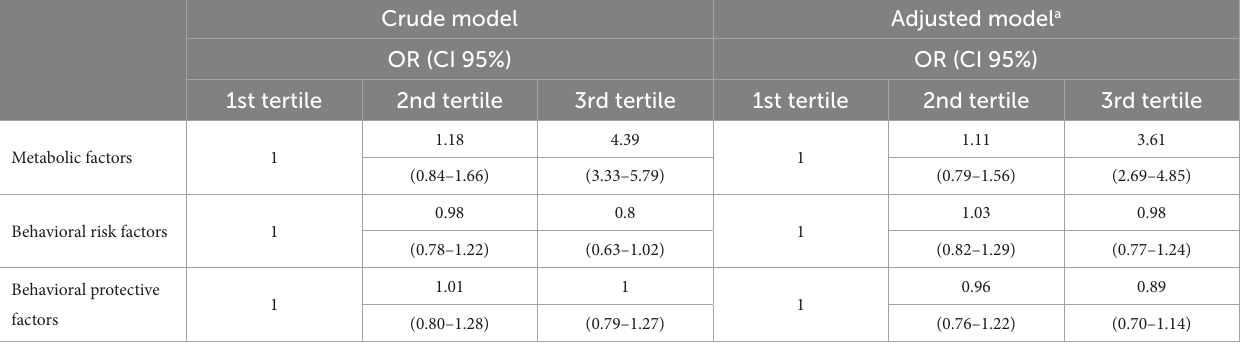
TABLE 3 Association of the three health-related patterns with CKD, by tertile. PNS,